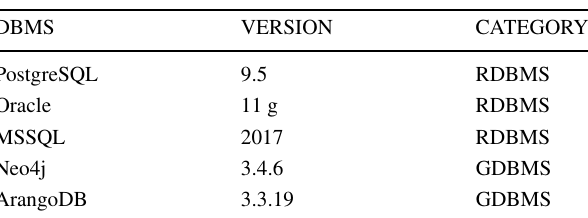
Table 7 Testing object